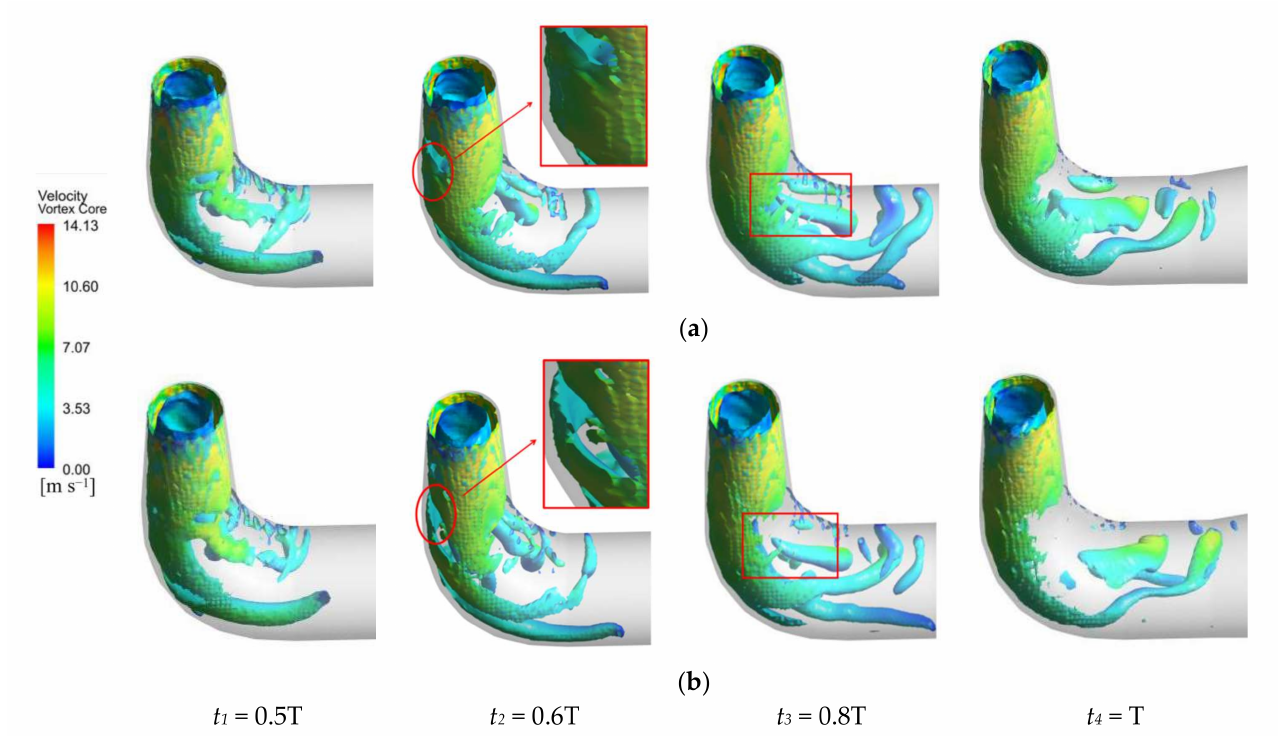
Figure 11. Comparison of the shape of the draft tube vortex before and after changing the airfoil. ( a ) Prototype. ( b ) After